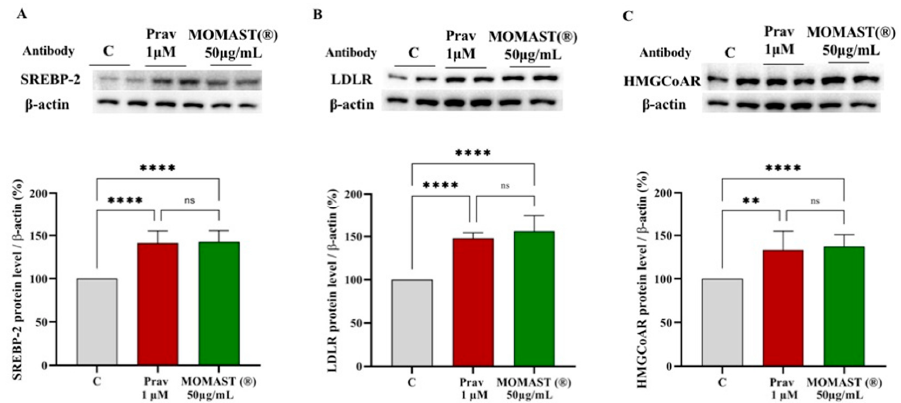
Figure 3. Effect of MOMAST ® (50.0 µg/mL) and Pravastatin (Prav) 1.0 µM on SREBP2 (Panel ( A )), LDLR (Panel ( B )), and the HMGCoAR (Panel ( C )) protein levels. Bars represent the averages of three independent experiments performed in duplicate ± SD, ns: not significant, (**) p < 0.01, (****) p < 0.0001 vs. control (C) . SREBP-2: sterol regulatory element-binding proteins; LDLR: low-density lipoprotein; HMGCoAR: 3-hydroxy-3-methylglutaryl coenzyme A reductase